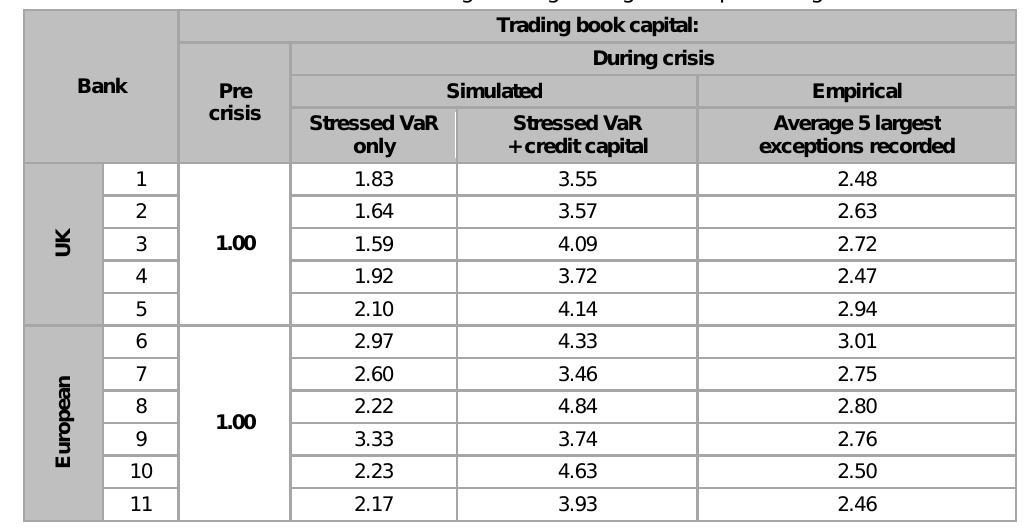
(sixth) column of Table 1: the average of the column measured for all 11 banks was